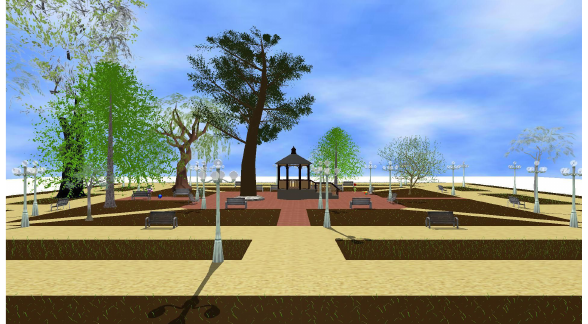
Figure 1. Be Civic Scenary